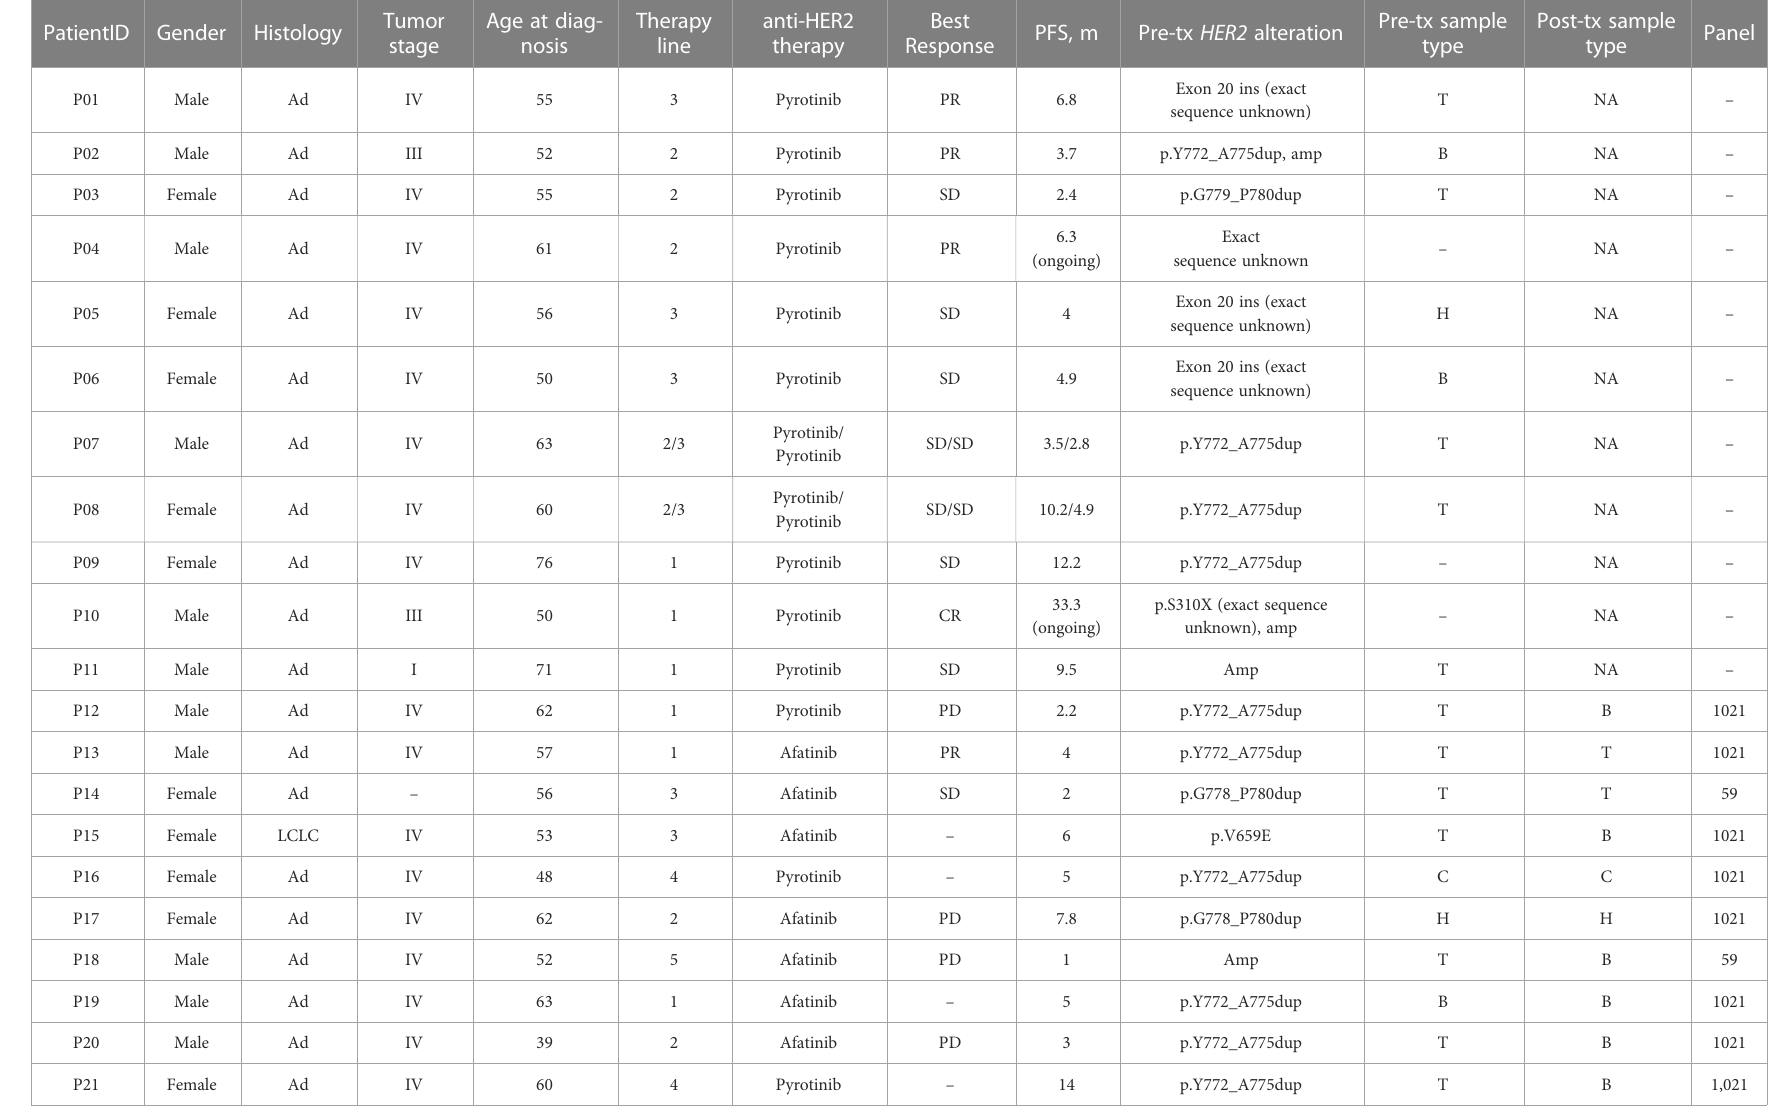
TABLE 4 Clinical and molecular features of patients with HER2 alterations treated with anti-targeted